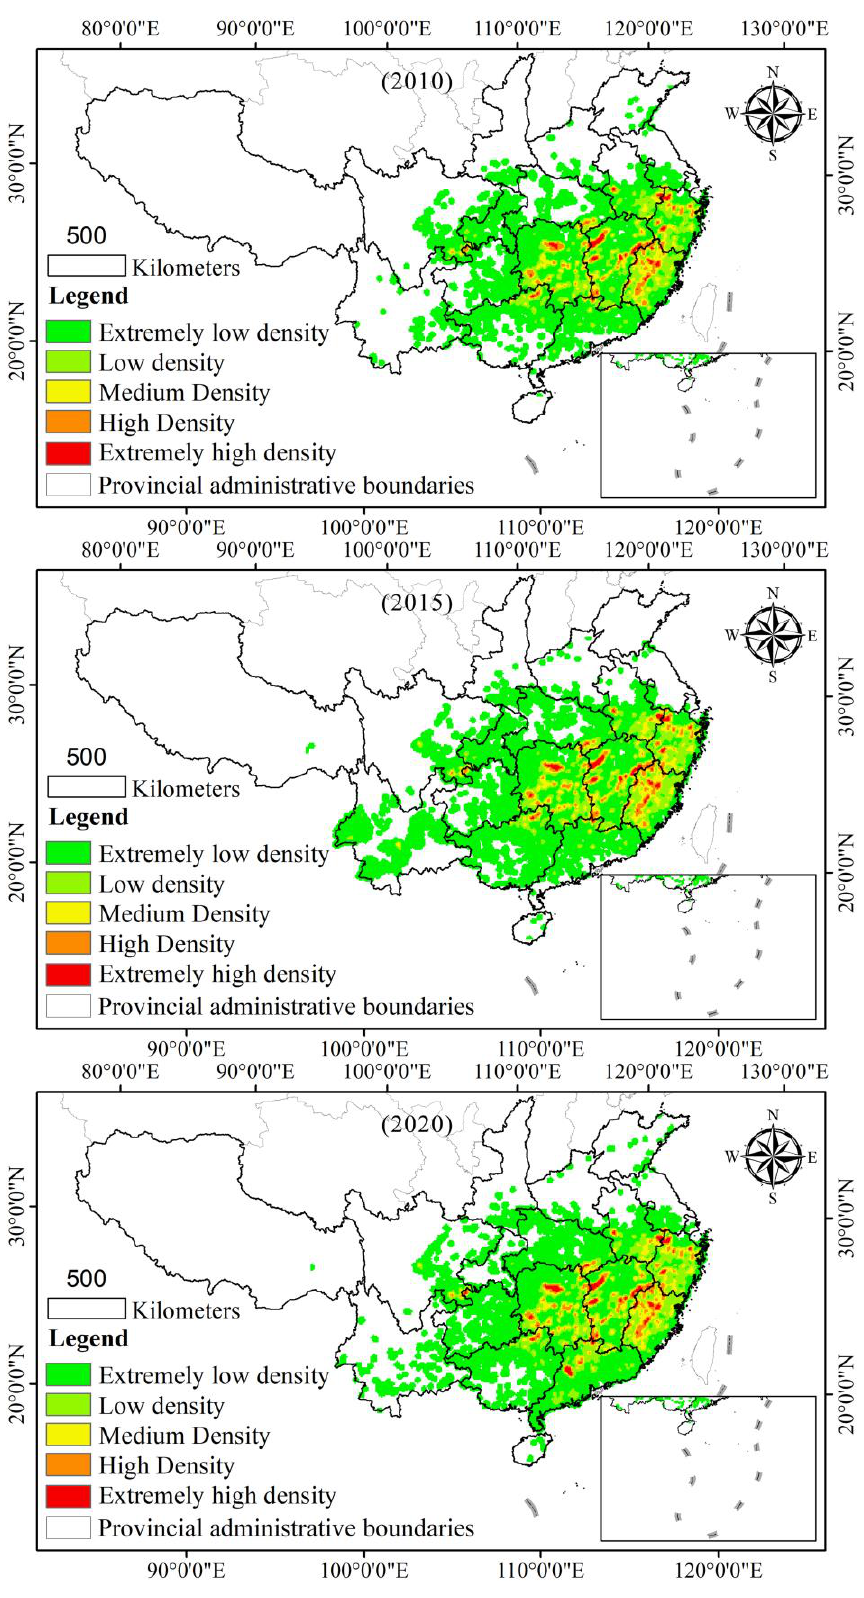
Figure 2. Spatial aggregation of bamboo forests nationwide in 2010, 2015, and 2020.